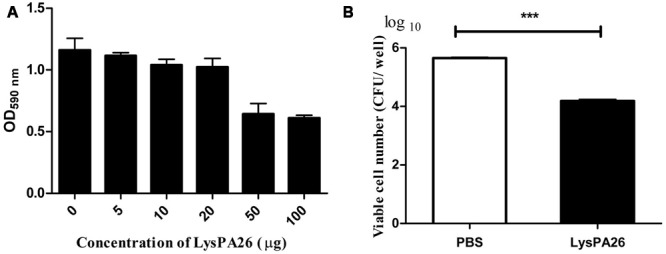
Biofilm eradication ability of LysPA26. Biofilm was grown on a polystyrene plate. (A) Biofilm eradication ability was determined by optical density analysis. (B) Eradication ability of LysPA26 was expressed as the discrepancy of the number of viable cells in the different treatments. ∗∗∗ Indicates significant difference (P < 0.001). Error bars represent the standard deviations of three independent assays.